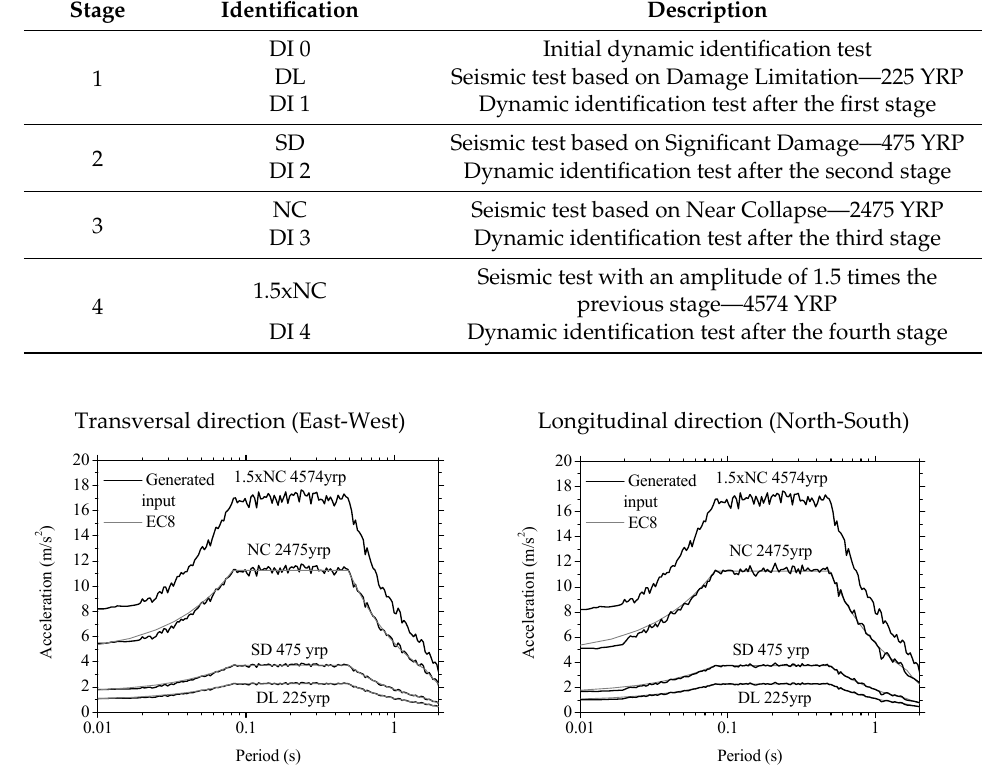
Figure 8. Comparison between the pseudo-acceleration response spectra of the accelerograms generated and the response spectra obtained from EC8 (scaled).